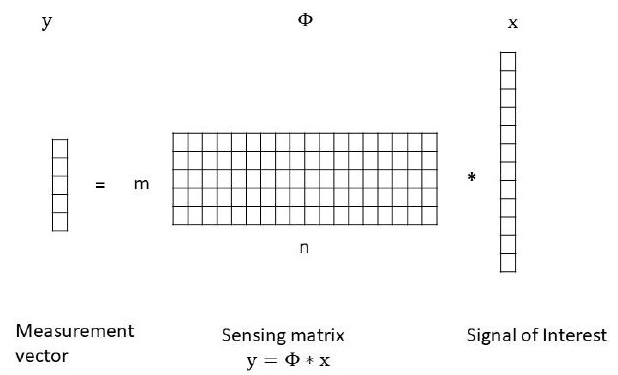
Figure 3. The CS sensing matrix.